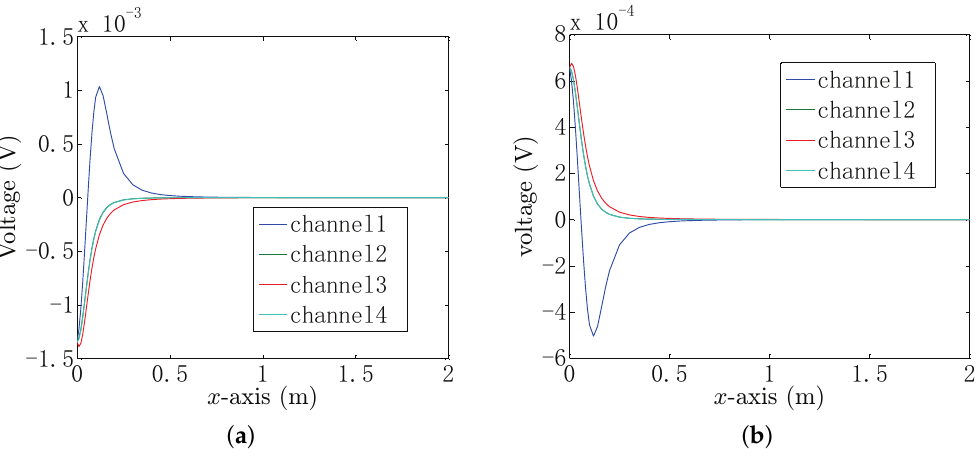
Figure 3. The the voltage of each channel of the UCA system when the target is set at position ( x ,0,0.1 ) . ( a ) Conductor target; ( b ) insulator